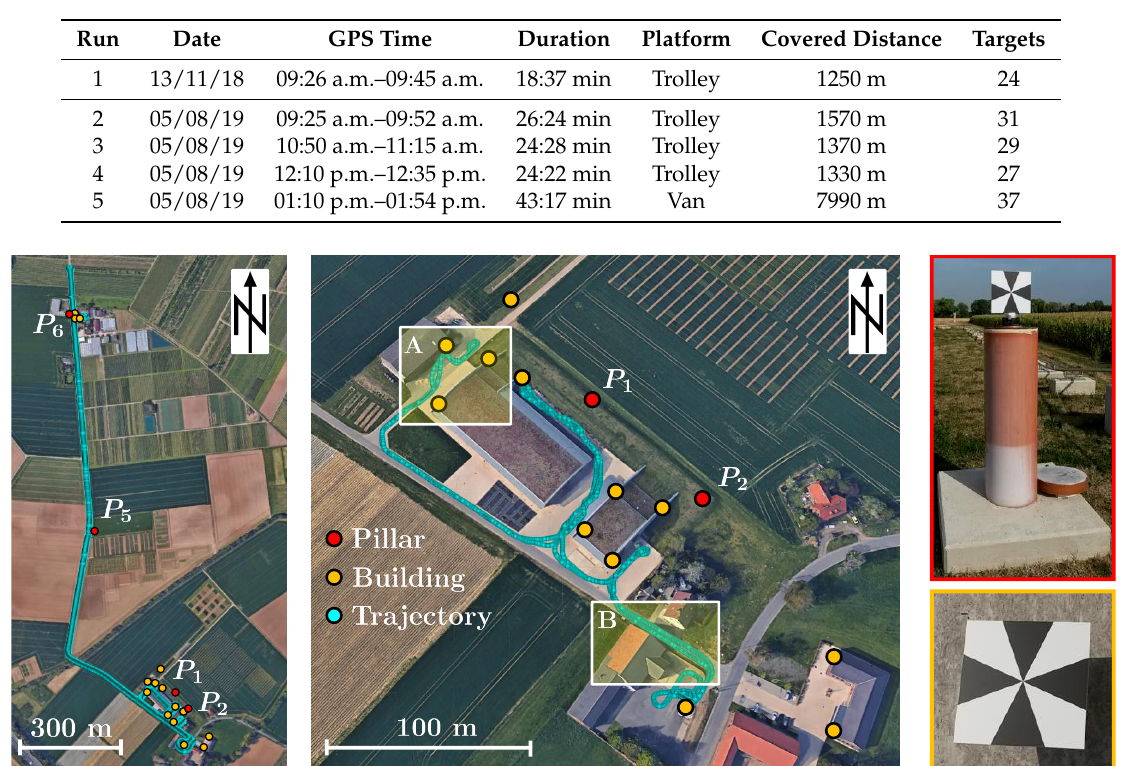
Table 4. Time schedule of the evaluation measurements in November 2018 and August 2019.